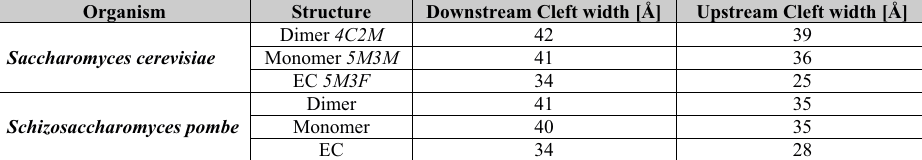
Fig. 4 Comparison of Sc and Sp Pol I structures. a Structural comparison of Pol I monomers (top) and ECs (bottom) in Sp (left) and Sc (right) displays the similar architecture of both enzymes. Upon EC formation, both Pol I versions contract their active sites (Supplementary Movie 1). b Comparison of Sp and Sc Pol I dimers. First monomer (cartoon tubes) overlaid via subunit A135. Second monomer (space- fi lling; Sp purple, Sc orange) is attached via upstream face but globally shifted in location. Increased cleft expansion compared to monomers is observed in Sc but not in Sp . This is likely a consequence of stalk insertion into the active center cleft and formation of the connector helix at the clamp core domain of the second monomer in Sc . Compare Supplemental Movie 2. c Quanti fi cation of cleft widths in Sc and Sp Pol I structures. In Sc structures, upstream width measured between residues Arg 434 in subunit A135 and Val 418 in subunit A190, downstream between Gly 231 and Lys 1331 in subunit A190. In Sp structures, upstream width measured between the corresponding residues Arg 409 in subunit A135 and Arg 425 in subunit A190, downstream between Lys 226 and Ser 1338 in subunit